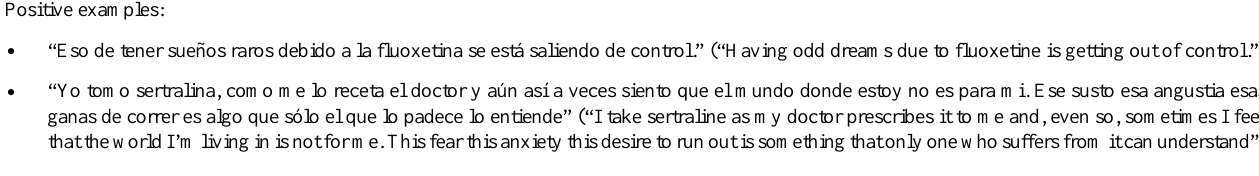
Table 3. Features of the tweets analyzed.